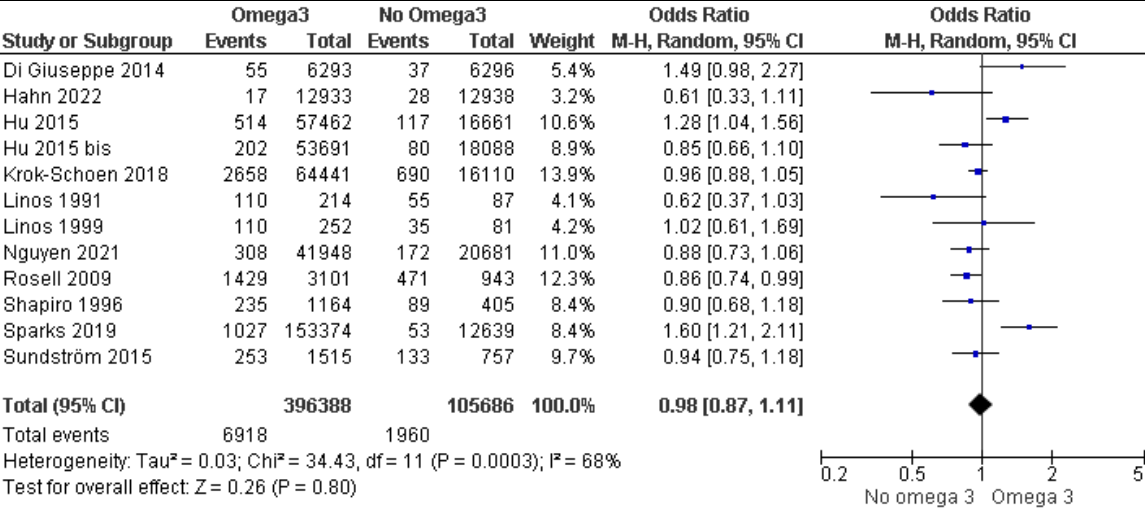
Figure 2. Forest plot of the risk of RA occurrence between omega 3 users and non-users.